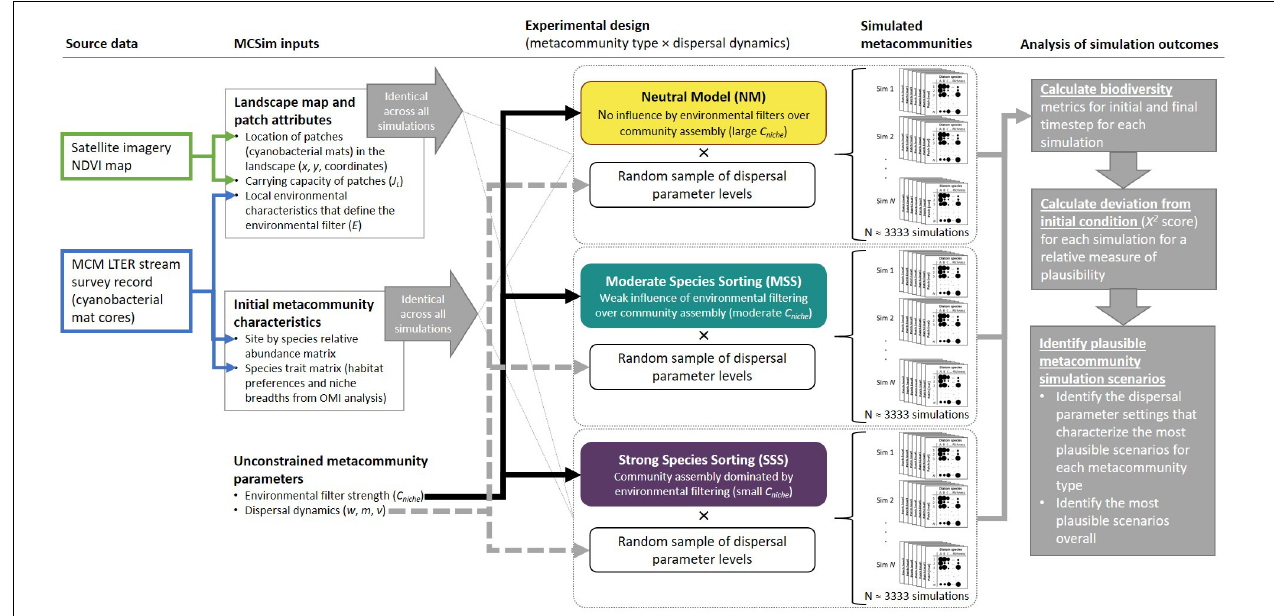
FIGURE 1 | Workflow to incorporate source data from the McMurdo Long Term Ecological Research (MCM LTER) program and remotely sensed imagery to constrain spatially explicit metacommunity simulations based on the MCSim framework to assess the plausibility of different metacommunity scenarios. Simulations that best maintained initial biodiversity levels were considered the most